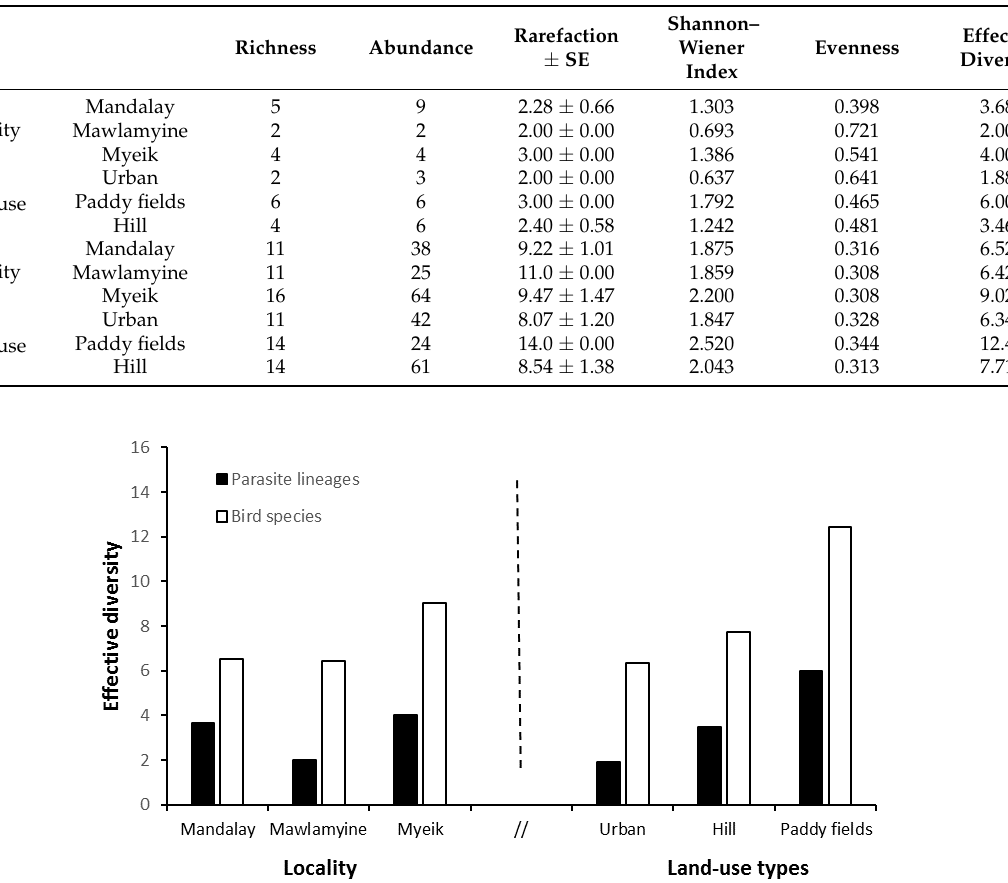
Figure 5. Bar chart showing the effective (true) diversity indexes for both parasite lineages (black bars) and avian species (white bars) in three localities and land-use types.